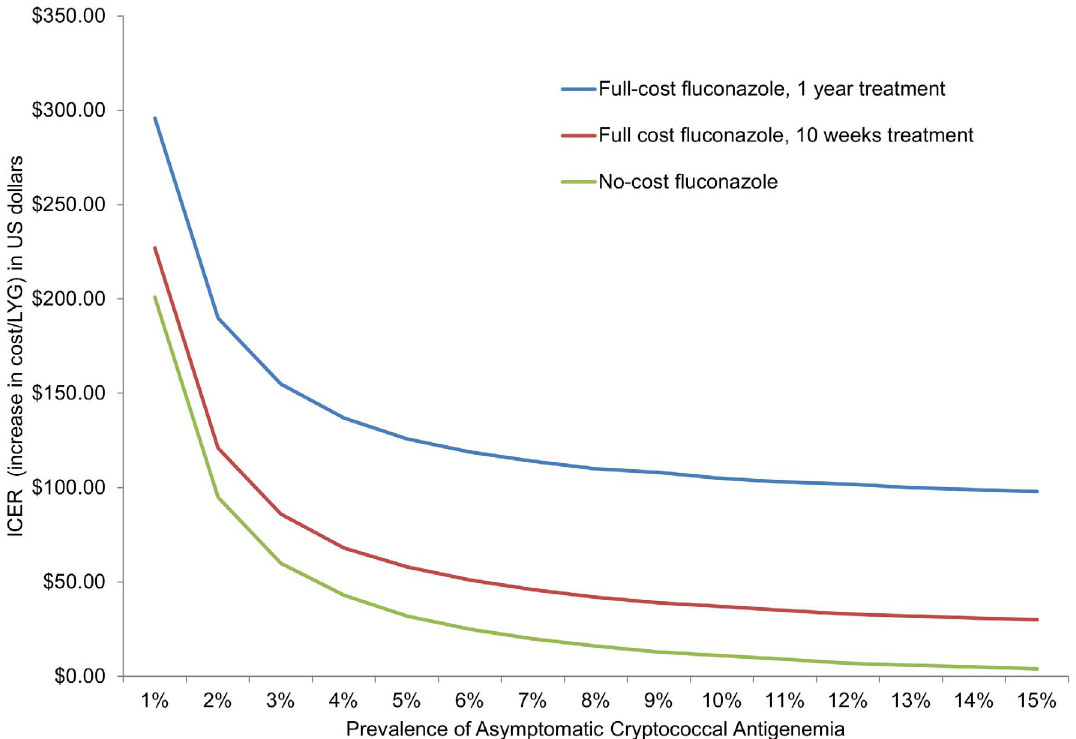
Figure 1. Cryptococcal screening algorithm. This algorithm, adapted from the South African national cryptococcal screening program, shows the flow of evaluation of HIV-infected patients in a model cryptococcal screening program. First, all patients with CD4 , 100 cells/mm 3